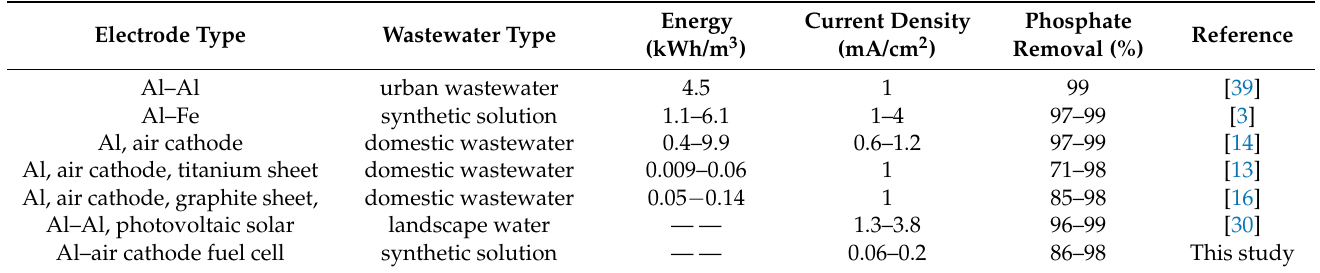
Table 2. Energy consumption of different electrocoagulation systems and the removal rates of phosphorus reported in different studies with Al